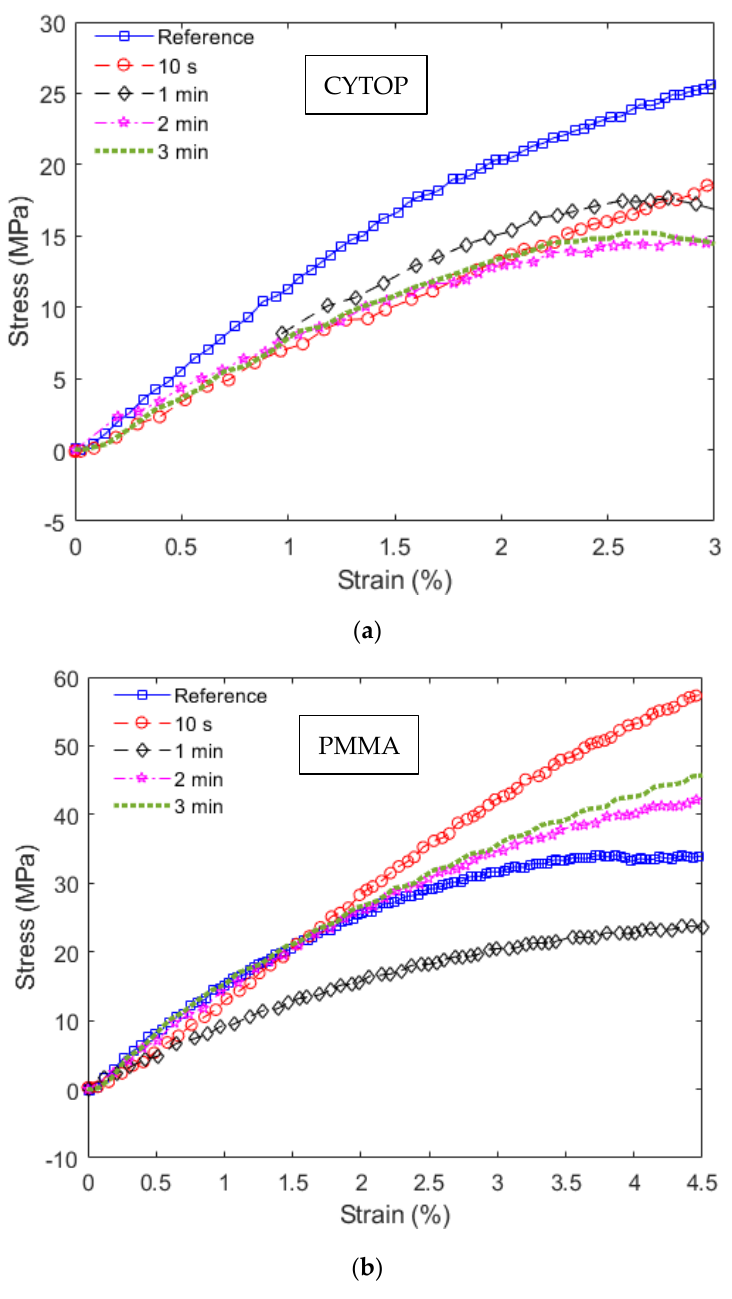
Figure 2. Stress–strain curves in static tests at different UV radiation conditions for ( a ) CYTOP fibers and ( b ) PMMA fibers.